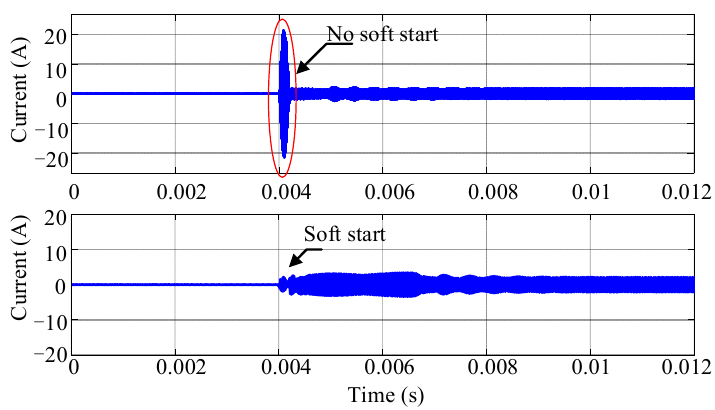
Figure 15. Comparison of resonant current with and without soft start.